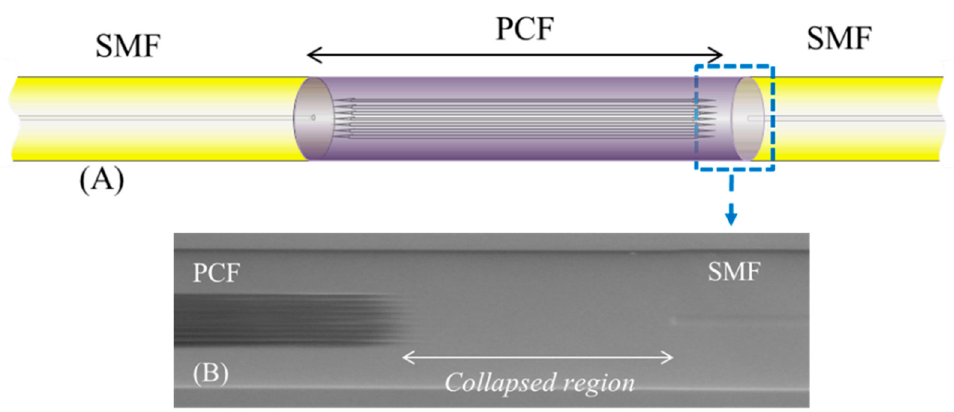
Figure11. ( A )SchemeofthesplicebetweenSC-PCFandSMF;( B )SEMphotoofthePCFcollapsedregion. Figure 11. (a) Scheme of the splice between SC-PCF and SMF; (b) SEM photo of the PCF collapsed region.